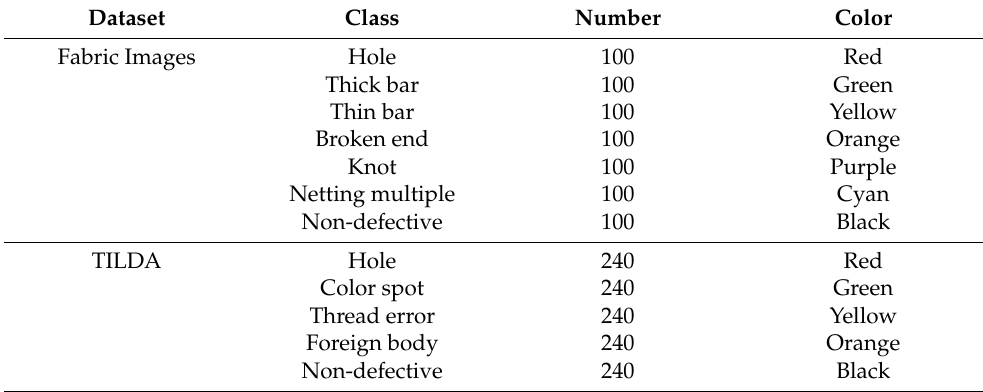
Table 2. Details of the